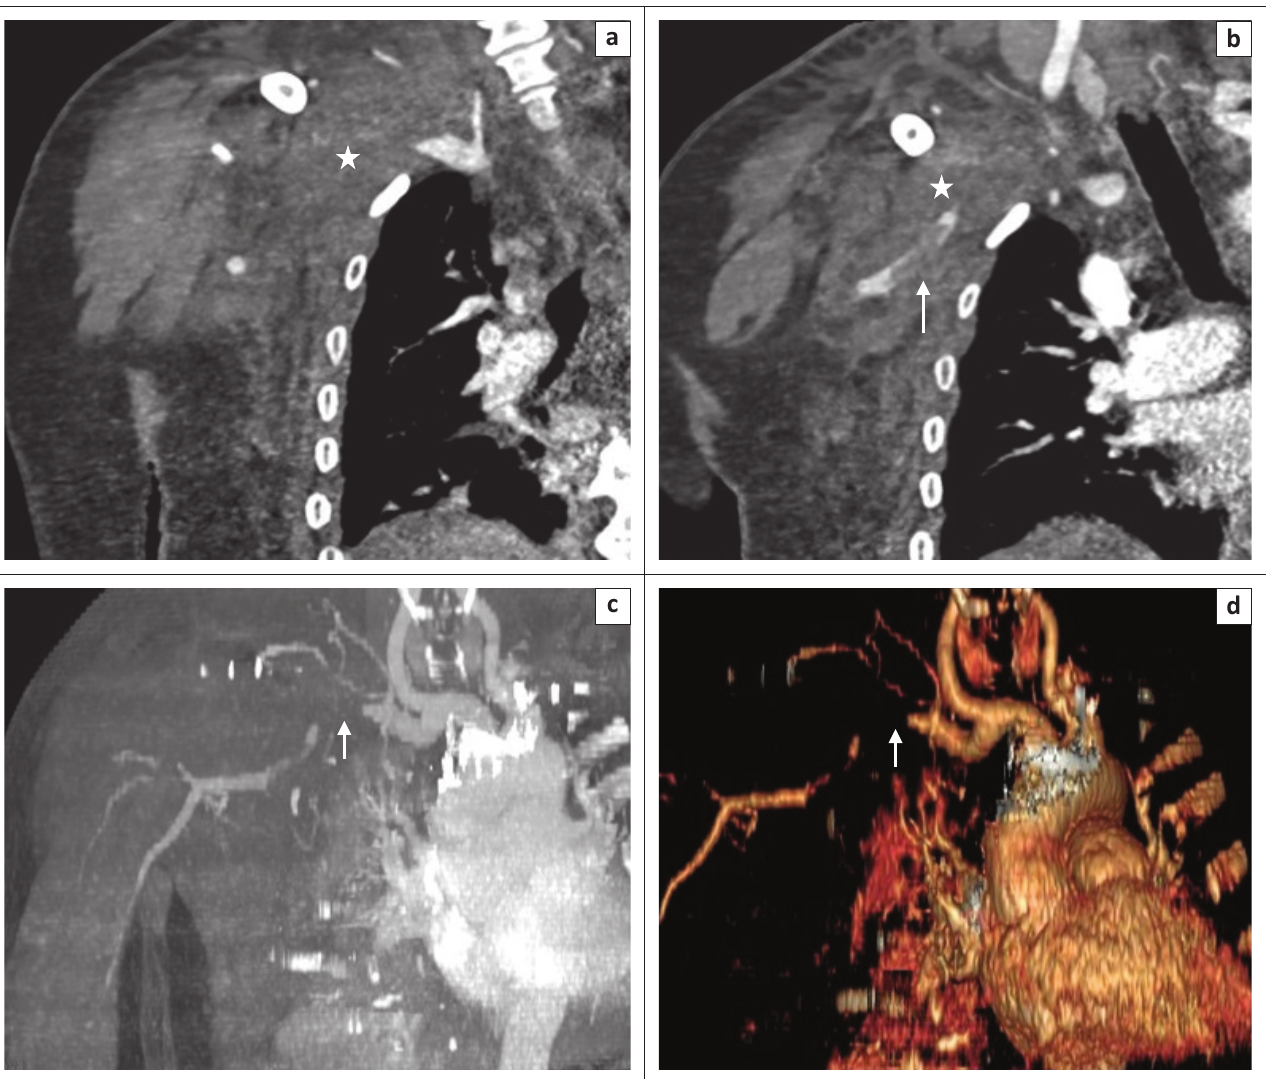
FIG URE 7: Subclavian artery occlusion and associated haematoma, seen as abrupt cut-off of the right subclavian artery in image (a), better demonstrated in image (c) maximum intensity projection reformat and image (d) 3D volume rendered image, with the